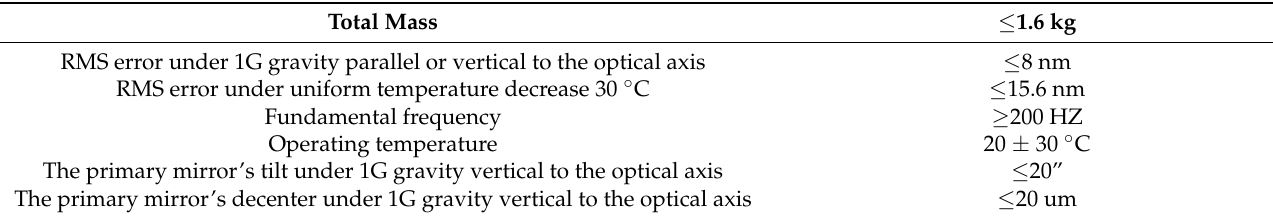
Table 1. Performance requirements of the primary mirror